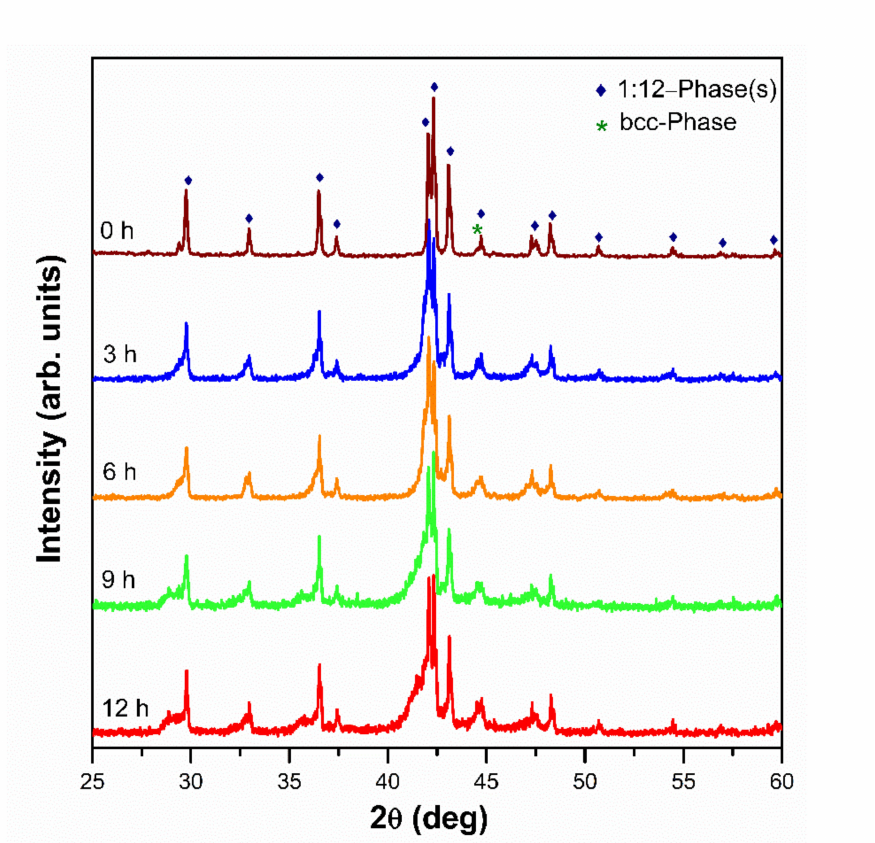
Figure 4. X-ray diffraction patterns of Nd 1.1 Fe 10 CoTi alloys nitrogenated from 0 to 12 h followed by